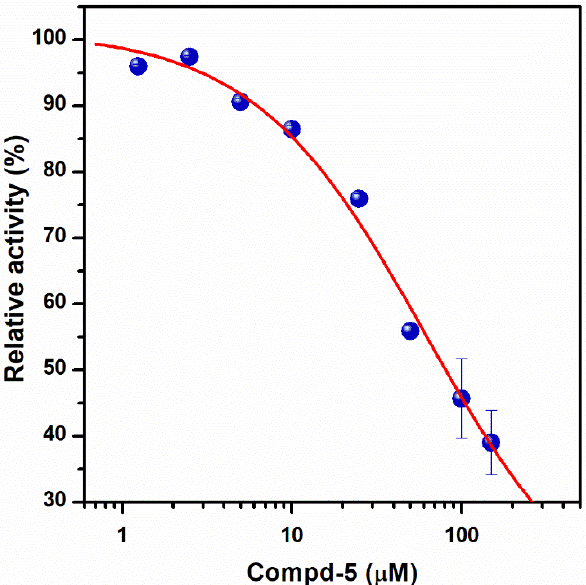
Figure 3. Dose-response plot of the inhibitory effect of Compd-5 on EcF 1 . Residual ATPase activity was measured using compound concentrations in the 1.25–150 µ M range, in a 100 mM Tris-SO 4 buffer solution with 1% DMSO (pH 8.0), 25 ◦ C. The Hill equation was fitted to the experimental data, obtaining IC 50 = 62 ± 5 µ M, h = 0.86 ± 0.02, v r = 9 ± 1%. Data shown represent the average ± standard deviation of 3 independent experiments.